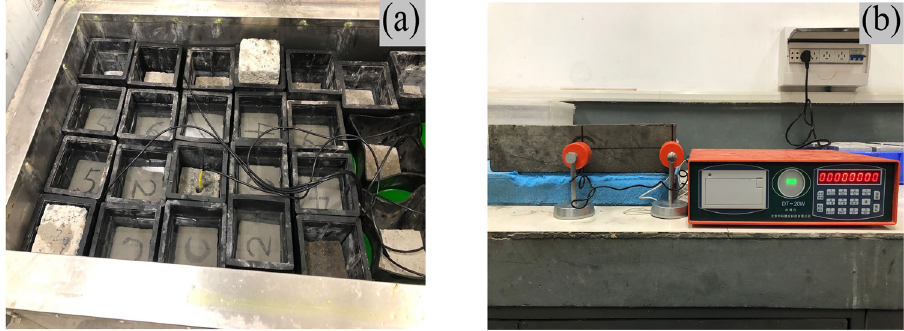
Figure 3: ( a ) Freezing - thawing specimens and ( b ) measurement of relative dynamic elastic